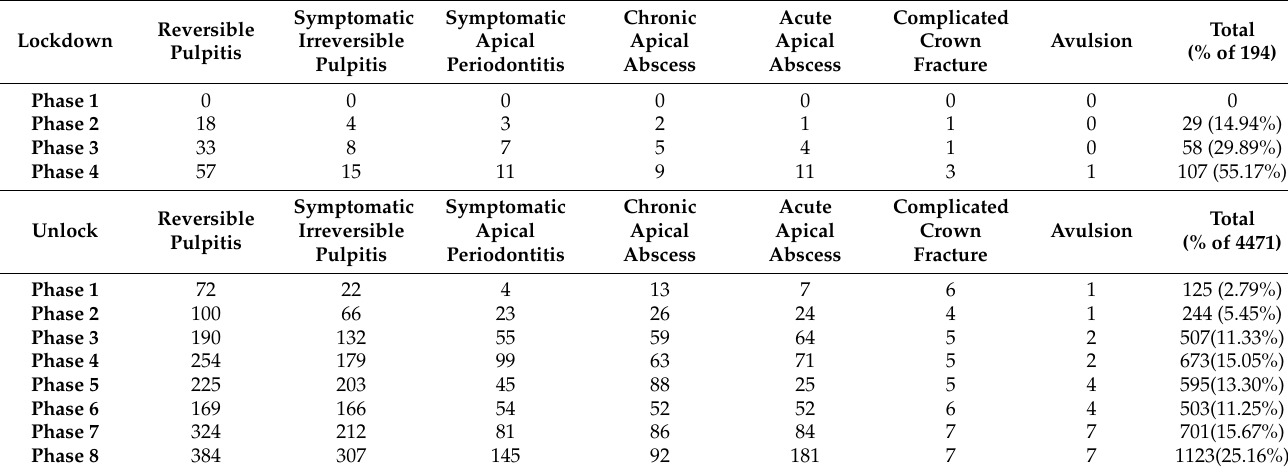
Table 4. Number of patients that visited the dental school for their first visit for different endodontic emergencies during lockdown and unlock phases.